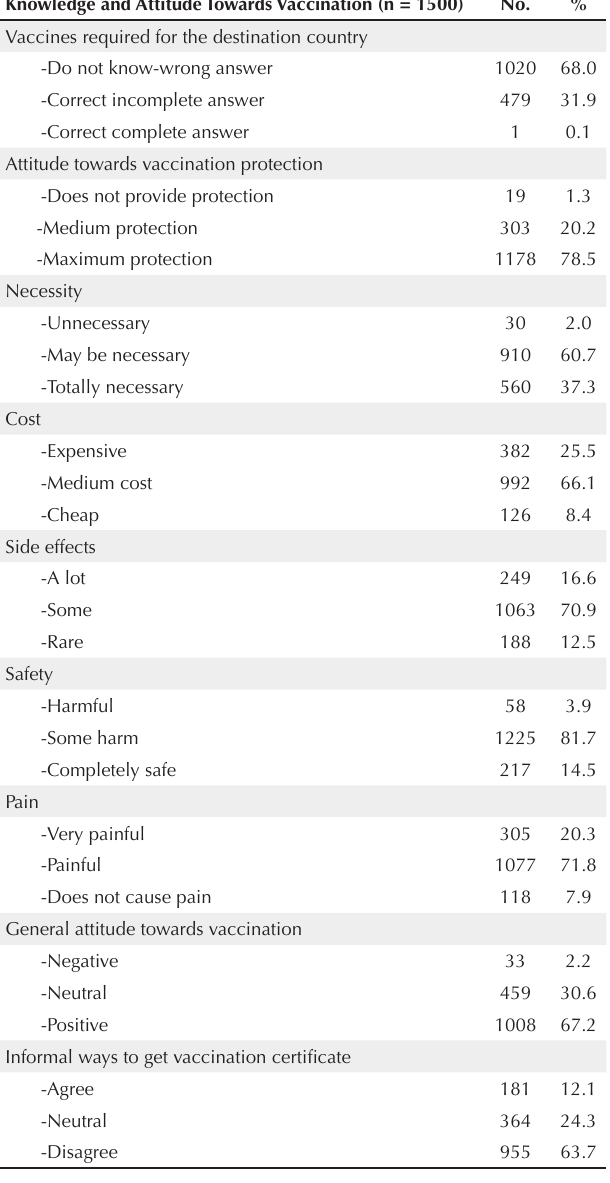
Table 2. Distribution of Travelers at Cairo International Airport According to Knowledge and Attitude Towards Vaccination Knowledge and Attitude Towards Vaccination (n = 1500) No.